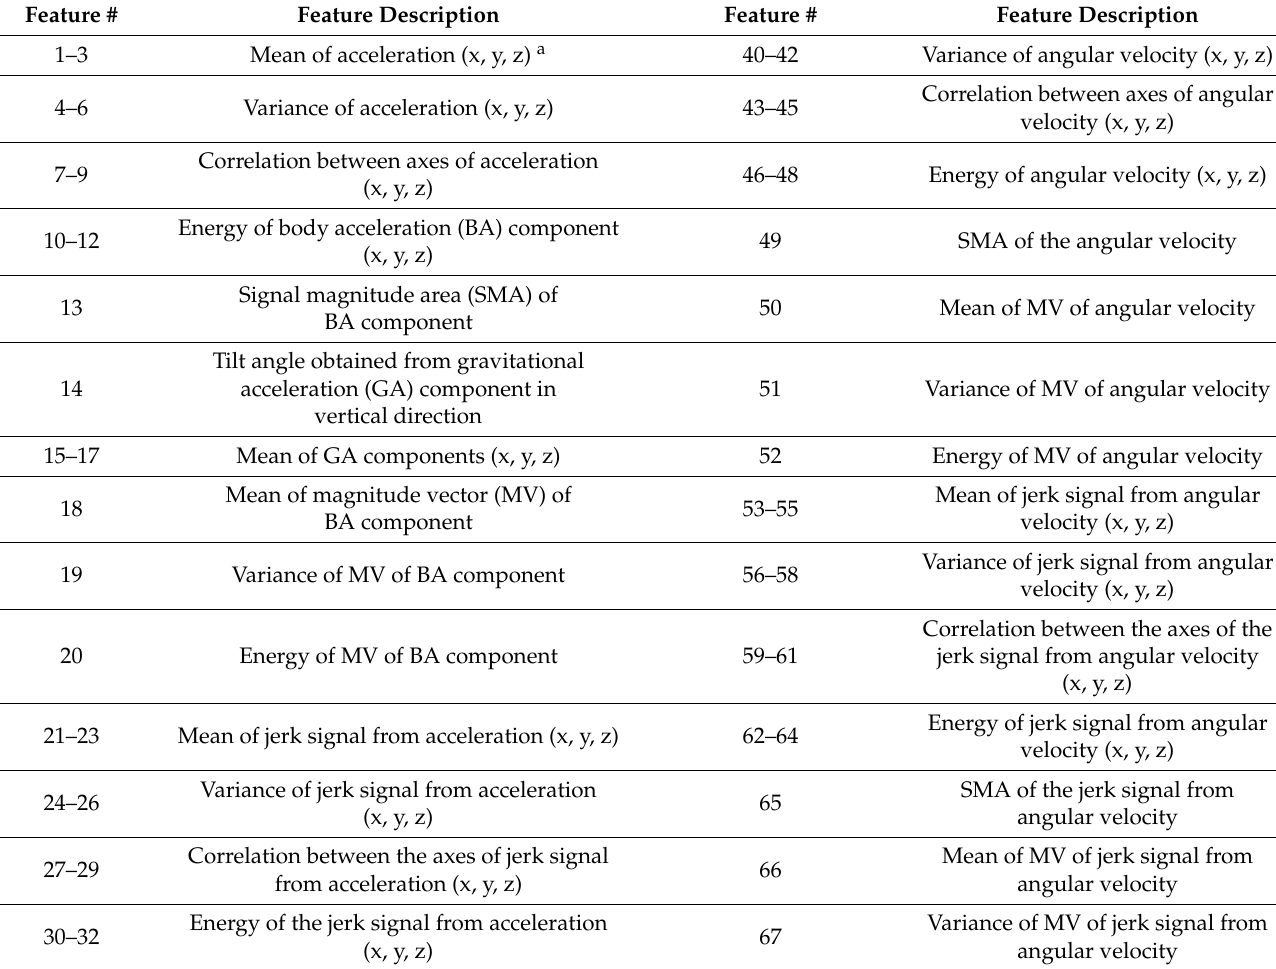
Table A1. Features Computed from Each